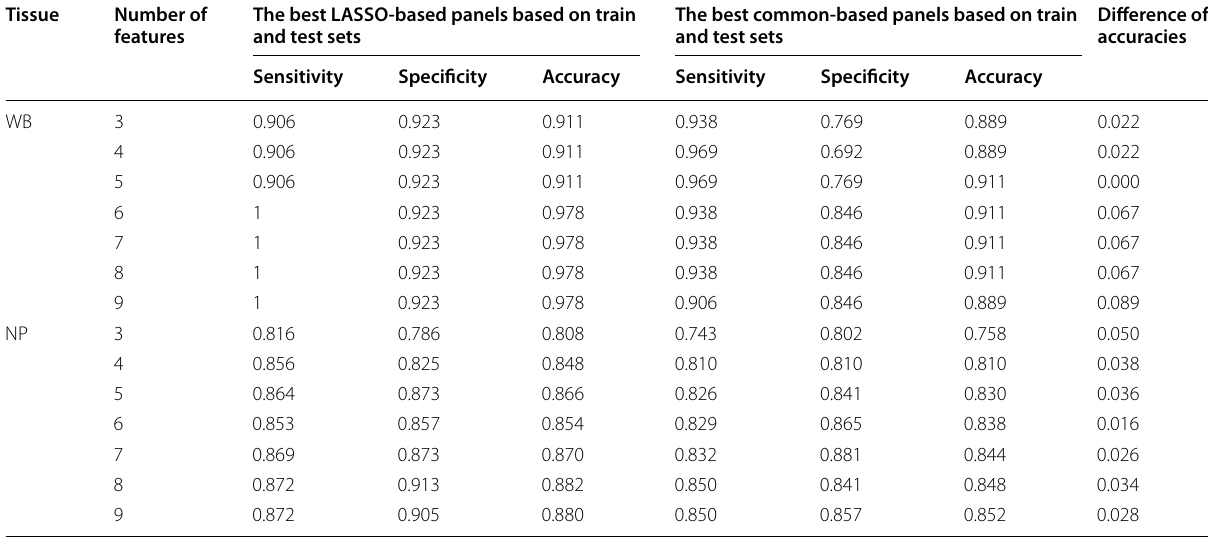
Table 4 The comparison of criteria related to the best panels of the LASSO feature-based prediction model and RF-based generic prediction